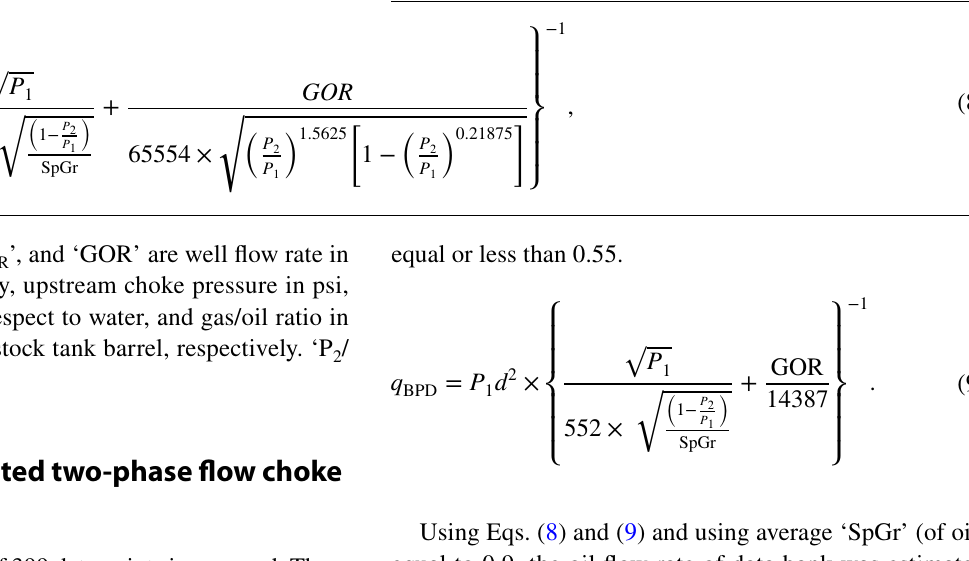
Fig. 2 Comparison of estimated oil well rate, Eqs. (8) and (9) with measured rate